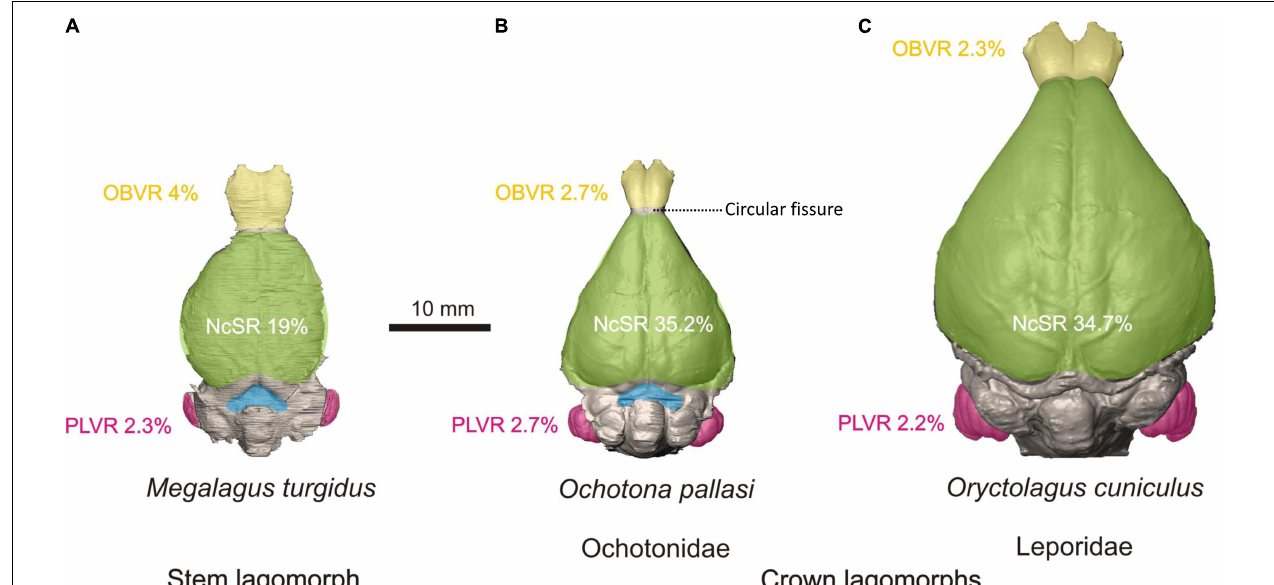
FIGURE 5 | Comparative morphology of the brain endocast in stem lagomorphs. ( A Megalagus turgidus ) and crown clades: Ochotonidae ( B Ochotona pallasi ) and Leporidae ( C Oryctolagus cuniculus ). The colors mark the brain areas of particular interest: yellow, olfactory bulbs; green, neocortical surface; blue, midbrain exposure; pink, petrosal lobules. See the comparative metric data of selected indices: NcSR, neocortical surface ratio (the ratio of the neocortex surface area to total endocast surface area); OBVR, olfactory bulb volume ratio (the ratio of the olfactory bulb volume to the total endocast volume); PLVR, petrosal lobule volume ratio (the ratio of the petrosal lobule volume to the total endocast volume); all indices are percentage values. The images and metrical data are taken from López-Torres et al. (2020).